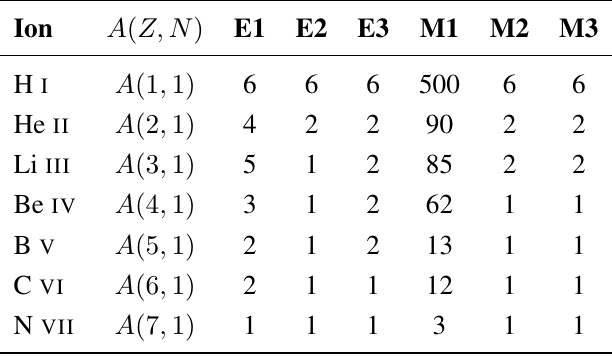
Table 1. Average permyriad ( 1 / 10 4 ) differences between the A -values computed with GRASP [98] for hydrogenic ions and the standard [100,101]. Allowed (E1) and forbidden (E2, E3, M1, M2 and M3) transitions between levels with principal quantum number n ≤ 5 in ( Z, N ) = (1 − 7 , 1) are